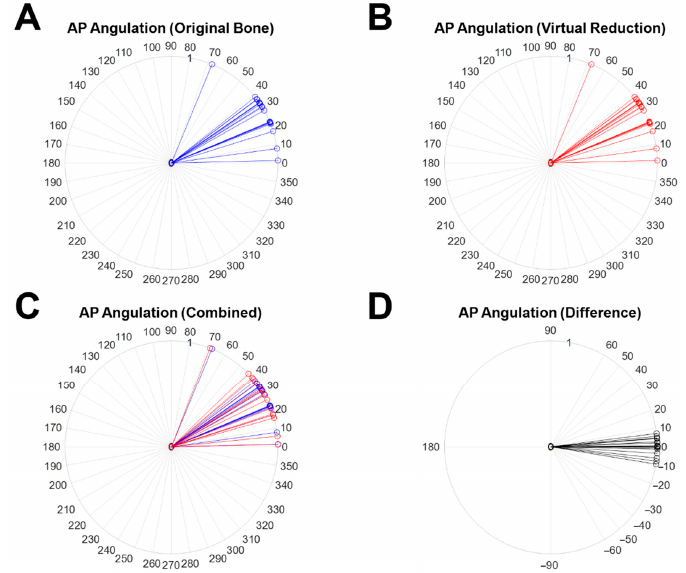
Figure 7. The measured 2D AP angulation on the YZ plane and the variation between the original object and the virtually reduced bone. ( A ) AP angulations measured from the angle between Normal Vector 1 and Normal Vector 2 (the original object), ( B ) AP angulations measured from the angle between Normal Vector 1 and Normal Vector 2 ′ (the virtually reduced object), ( C ) overlapped re- sults for ( A ) with blue lines and ( B ) with red lines, and ( D ) the difference (black line) in AP angula- tion between ( A ) with blue lines and ( B ) with red lines. Figure 8 shows the results of lateral angulation measured from the 2D angle on the XZ plane and the variation. Figure 8A, B present the lateral angulation of the original ob- ject (blue line) and the virtually reduced object (red line), respectively. The overlapping results of both cases (blue line; lateral angulation measured in the original object (red line; lateral angulation measured in the virtually reduced object) are shown in Figure 8C. The difference in the lateral angulations is shown as a black line in Figure 8D. The mean lateral angulation variation was 0.09° with SD: 0.13° The maximum and minimum variations were 0.54° (Case 19) and 0.00° (Case 4 and Case 18), respectively. There was no statistical difference (h = 0) between the two samples with a p -value of 0.9986 in the paired t -test.